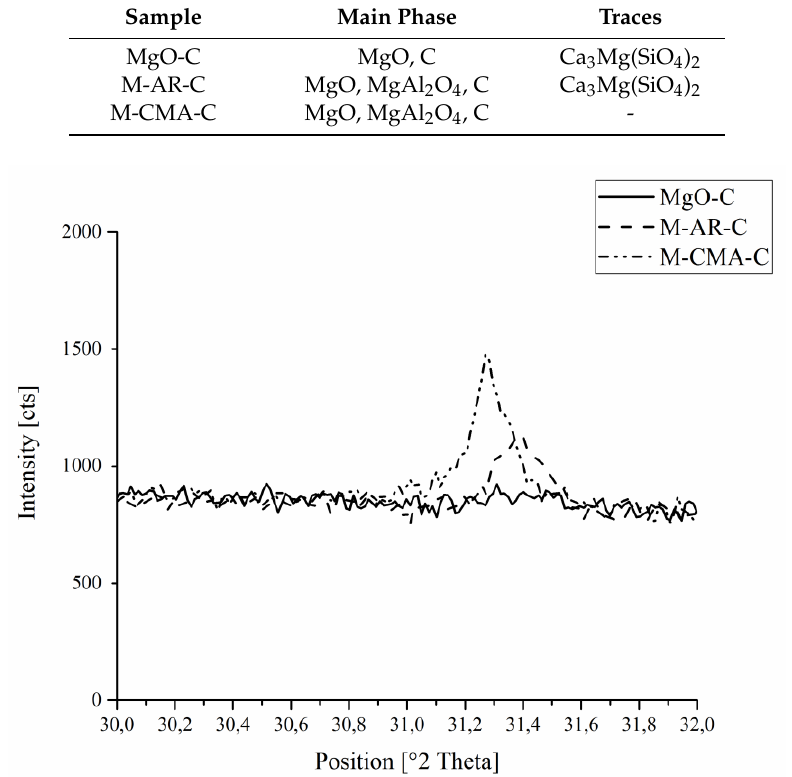
Table 4. Main and trace phases after carbonization at 1400 °C.